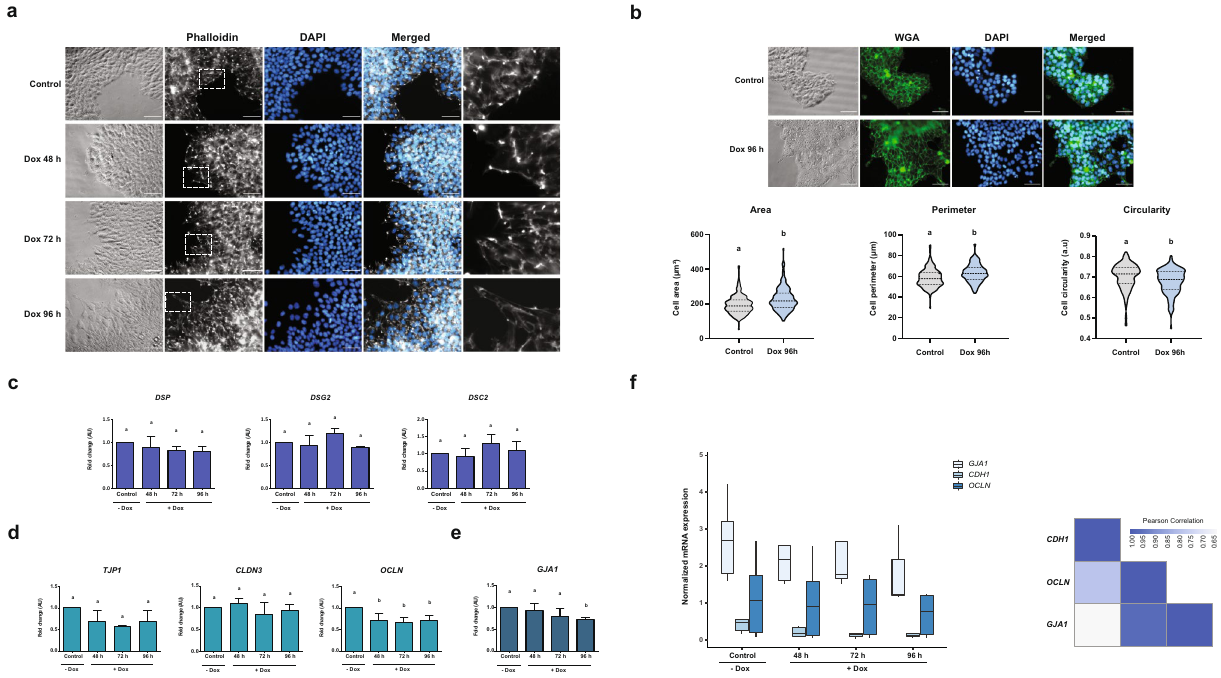
Figure 2. Downregulation of E-cadherin induced morphological alterations and transcriptional regulation of some adhesion complex genes. a ) Morphological changes of HES3-KRAB CDH1 cells incubated with Dox at different times. Cells were stained with phalloidin (grey) to visualize F-actin and DAPI was used to stain the nucleus (blue). Magnifications of areas indicated by dotted lines are shown in the last column in black and white colors. Scale bar 50 µm. b ) Cellular size and shape analysis of HES3-KRAB CDH1 cells. Cell membranes were defined by wheat germ agglutinin (WGA) labeling after incubation without Dox (Control) or with Dox during 96 h (96 h). Upper panel: representative images of cell membrane stained with WGA (green). Nucleus were stained with DAPI (blue). Scale bar 50 µm. Lower panel: graphical representation of quantification of cell area, perimeter and circularity. AU is the abbreviation for arbitrary units. ( c ) Relative mRNA expression of desmoplakin ( DSP ), desmoglein ( DSG2 ), desmocollin ( DSC2 ) ( d ) tight junction protein 1 ( TJP1 ), claudin 3 ( CLDN3 ), occludin 1 ( OCLN ) and ( e ) connexin 43 ( GJA1 ), when E-cadherin is downregulated. AU is the abbreviation for arbitrary units. Results are represented as mean ± SD (n = 5). ANOVA with post hoc Tukey. Different letters indicate significant differences of groups compared to control condition (p < 0.05). ( f ) Left: normalized mRNA expression of E-cadherin ( CDH1 ), occludin-1 ( OCLN ) and connexin 43 ( GJA1 ) genes. Right: heat map showing Pearson’s correlation coefficient between these